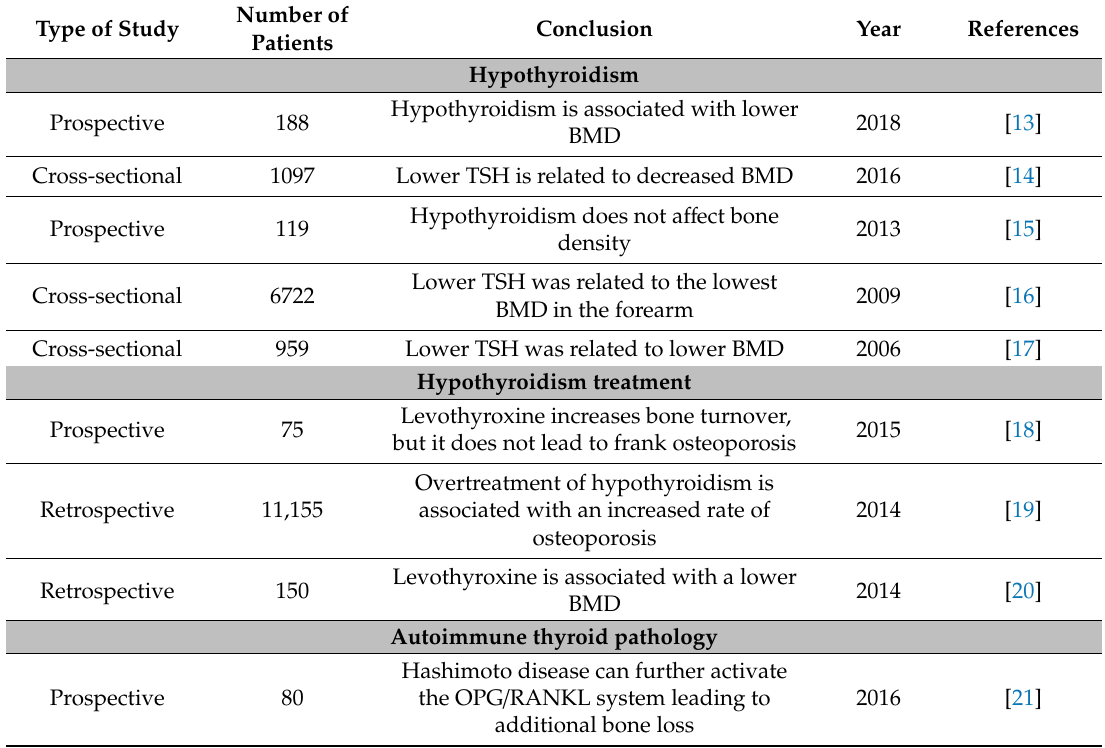
Table 1. Studies regarding the impact of hypothyroidism, autoimmune thyroid pathology, subclinical hypothyroidism, subclinical hyperthyroidism, and their treatments on bone mineral density. BMD = bone mineral density; OPG = osteoprotegenrin; RANKL = receptor activator of nuclear factor kappa-B ligand; TSH = thyroid-stimulating